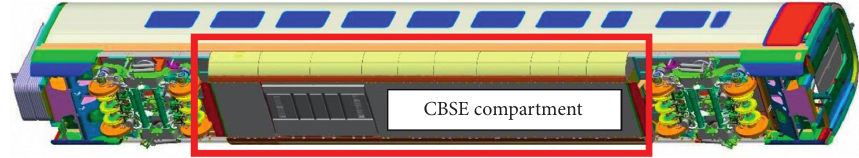
Figure 1: A 3D drawing of the arrangement of CBSE on the